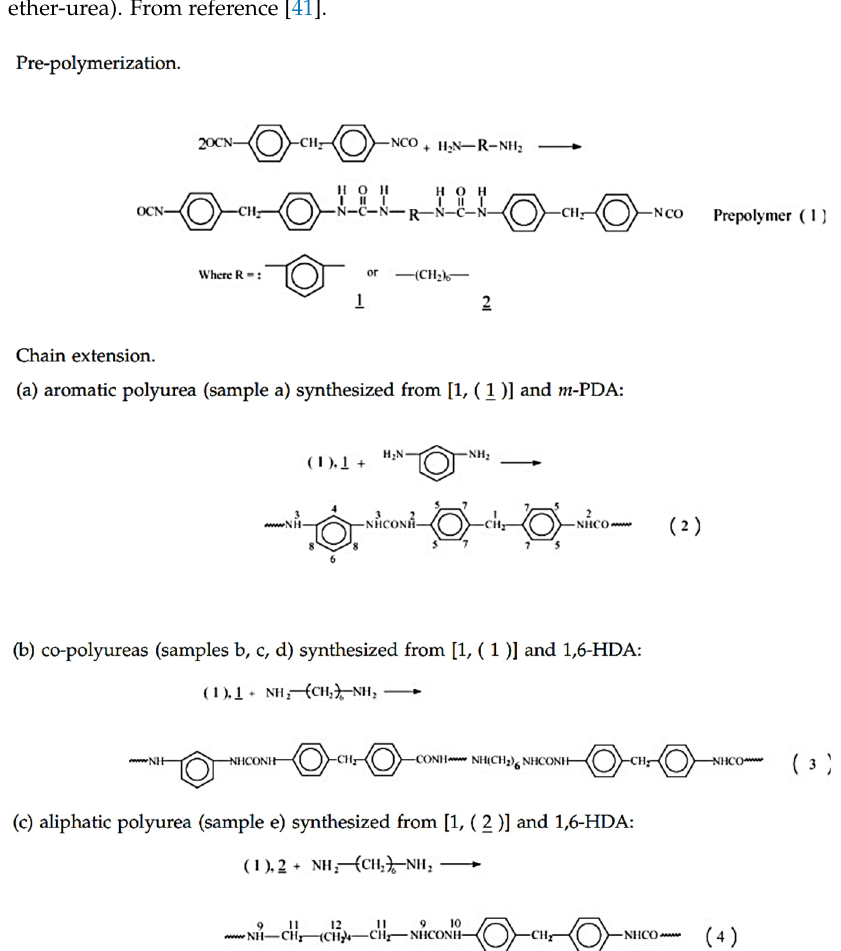
Figure 11. Typical polyurea polymerization reactions, adapted from reference [42]. The monomer composition of their samples is listed in Table 1 [42]. Table 1. Monomer compositions and the intrinsic viscosity of the polyurea samples. From reference [42].